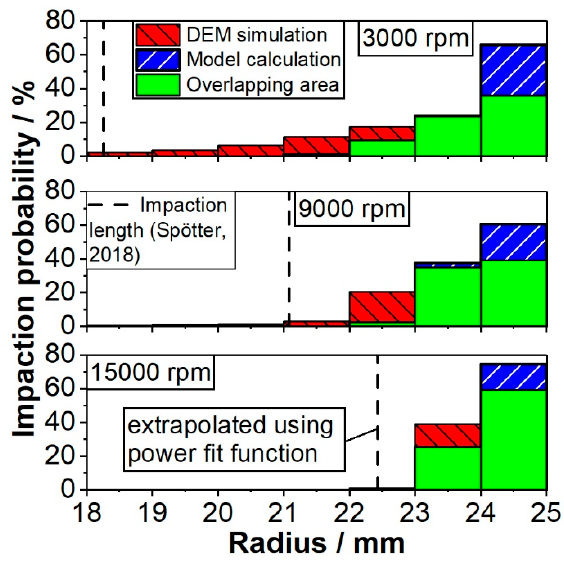
Figure 10. Impaction probability versus radius calculated in DEM simulations with the influence of drag, calculated in the model without the influence of drag, and the impaction length measured by Spötter et al. [30].